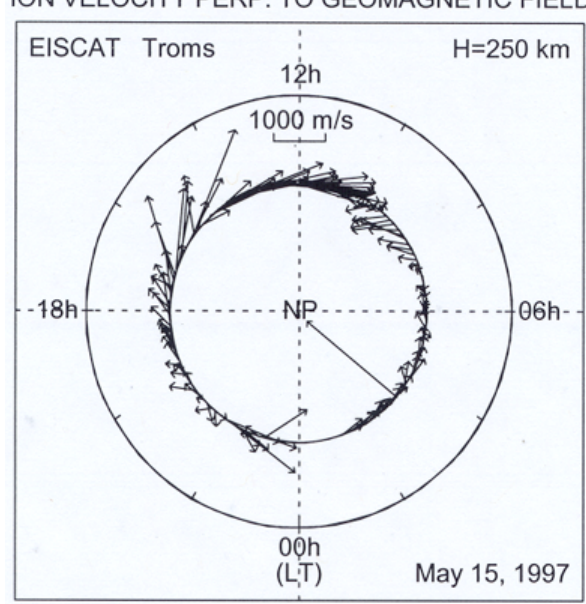
Fig. 3. The ion velocity perpendicular to the geomagnetic field ob- served by EISCAT. A significant reversal occurred around 10:00 LT.